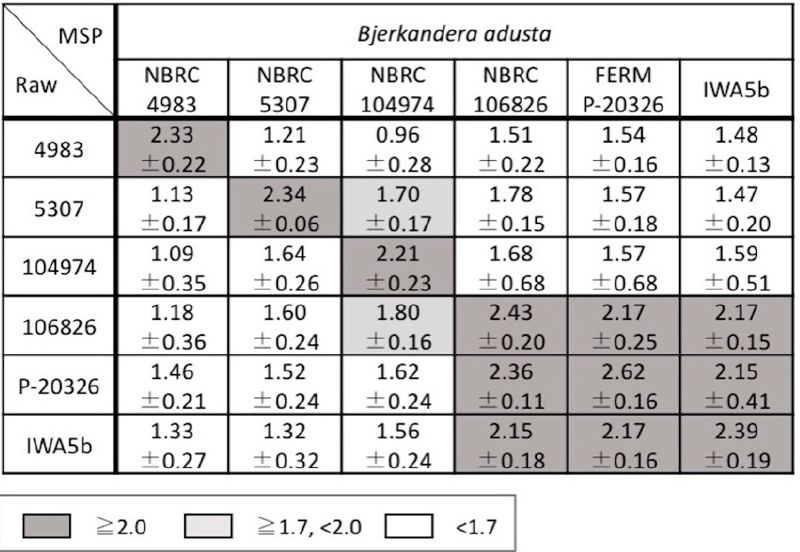
Figure 4. Average identification scores of raw mass spectra and the MSPs of Bjerkandera adusta . The scores presented are between 0 and 3: ≥ 2.0 (gray cells) was accepted for reliable identification to the species level; ≥ 1.7 and < 2.0 (light gray cells) was accepted for identification to the genus level; and < 1.7 (white cells) indicated unreliable identification of fungi.